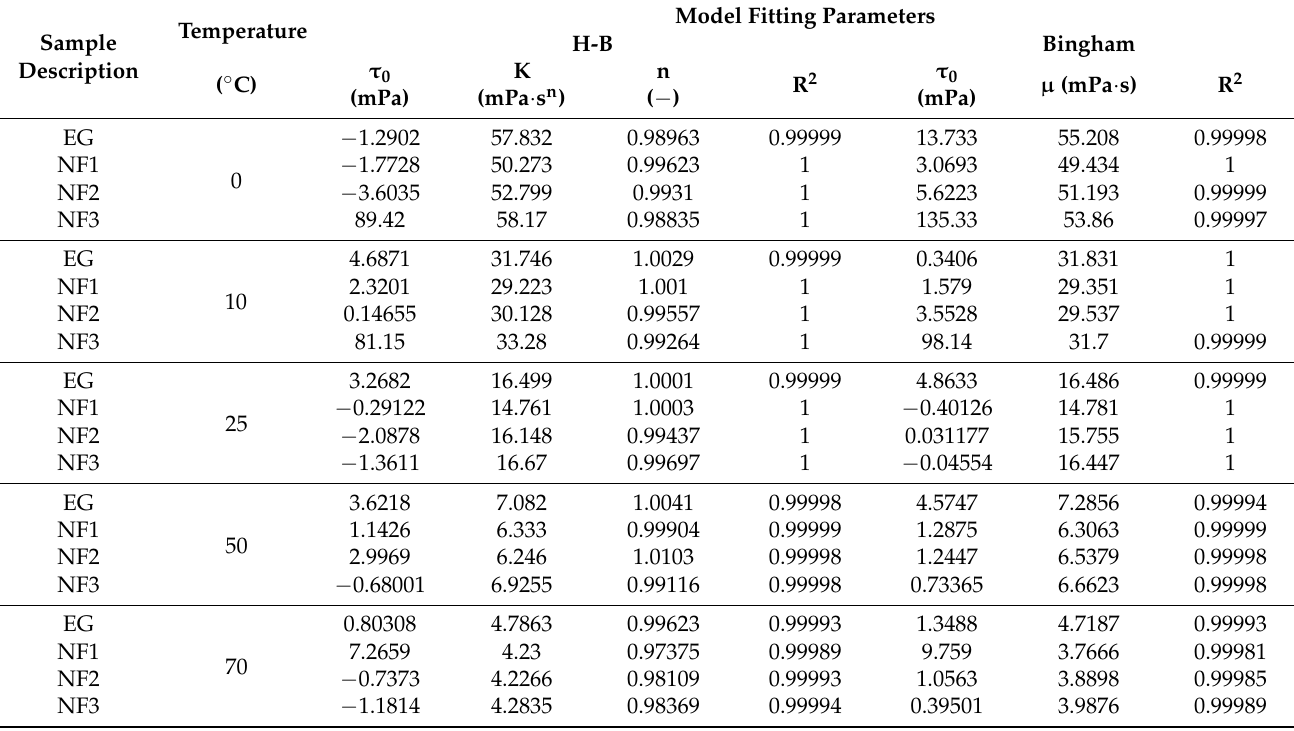
Table 3. H–B and Bingham Model fitting